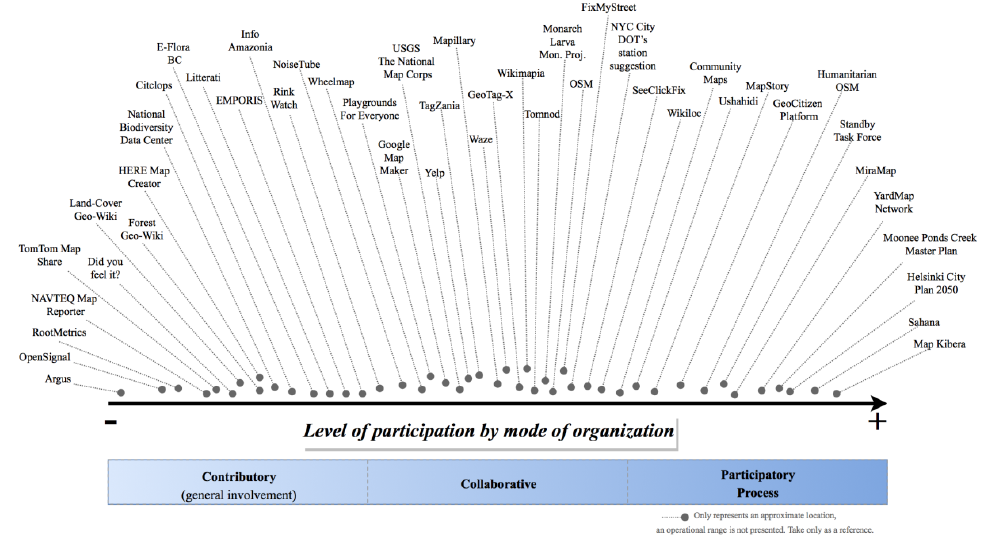
Figure 6. VGI Projects by Approximate Level of Participation by Mode of Organization.